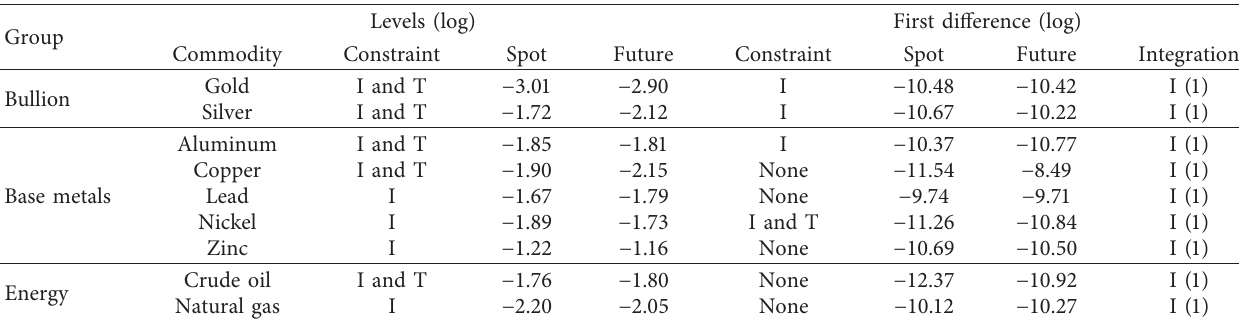
Table 6: Unit root test of spot and futures prices (level and difference) for the selected commodities.